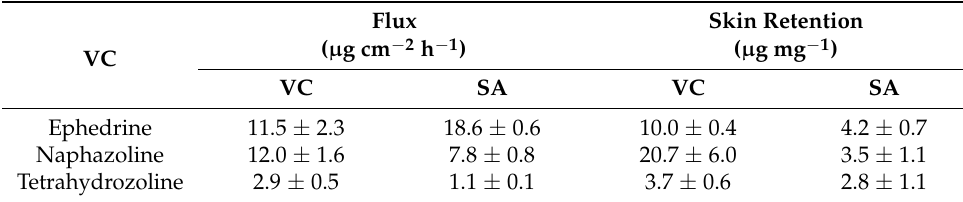
Table 20. Epidermal flux and tissue retention of VCs and SA following application to human skin. Concentrations applied were 10% w / v of equimolar amounts of SA and VC ( n = 6, values represent the mean ± S.E). Used with permission from [51], Springer Nature, 2003.